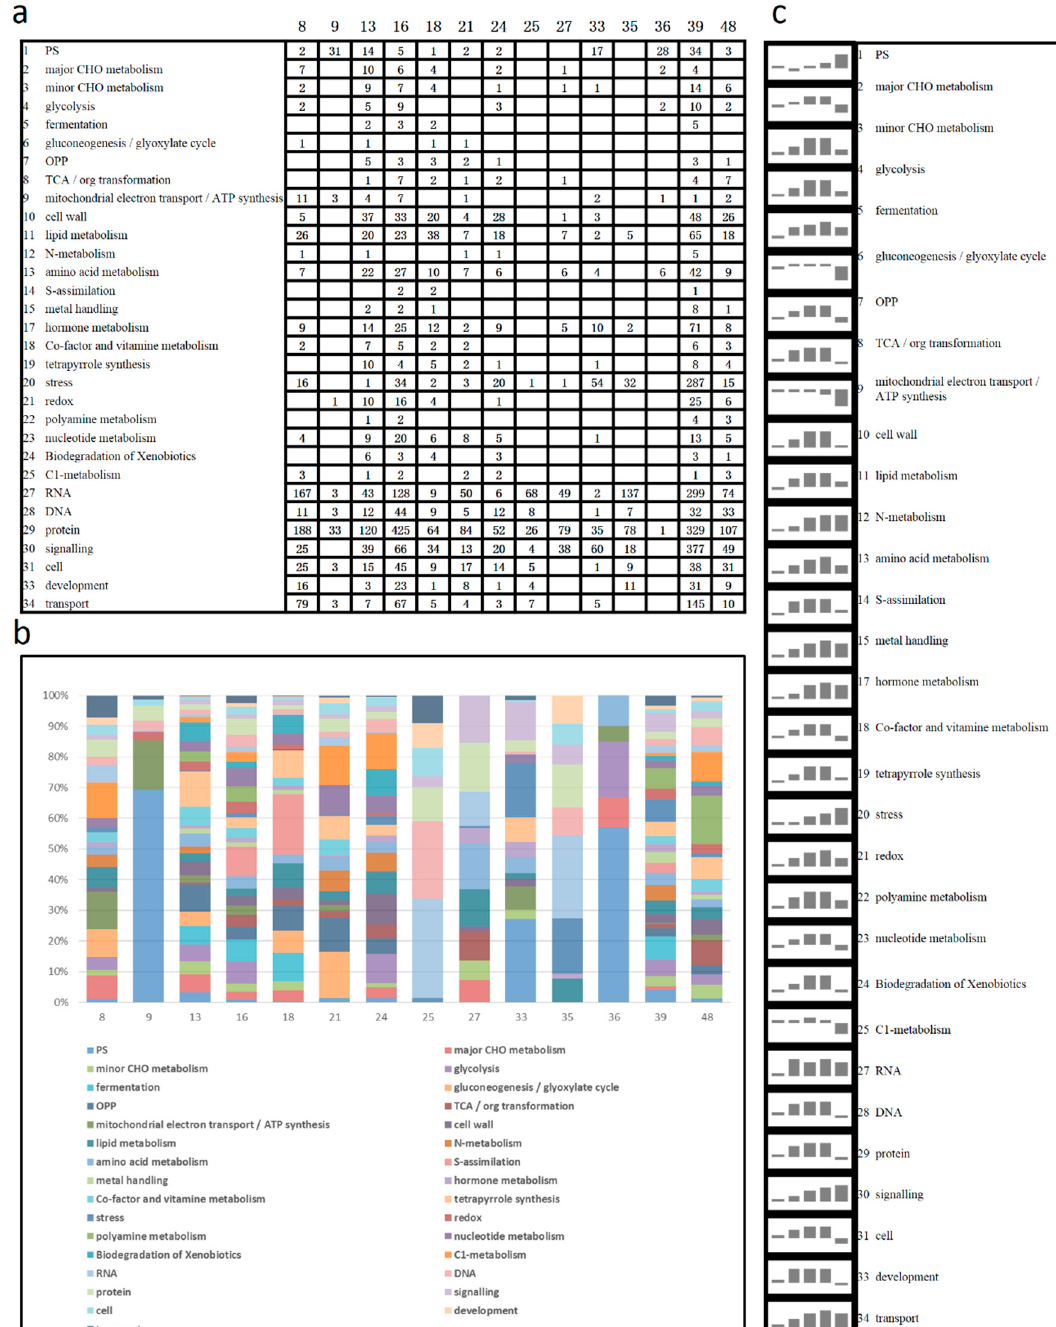
Figure 3. Pathway analysis of the di ff erentially expressed genes in each cluster. ( a ) Pathway analysis of the type of gene in each cluster. The numbers in the boxes indicate the numbers of genes in the functional category. ( b ) The proportions of the numbers of genes in the di ff erent functional categories in each cluster after homogenization. ( c ) The average weighting method was used to calculate the gene expression activity of each pathway.